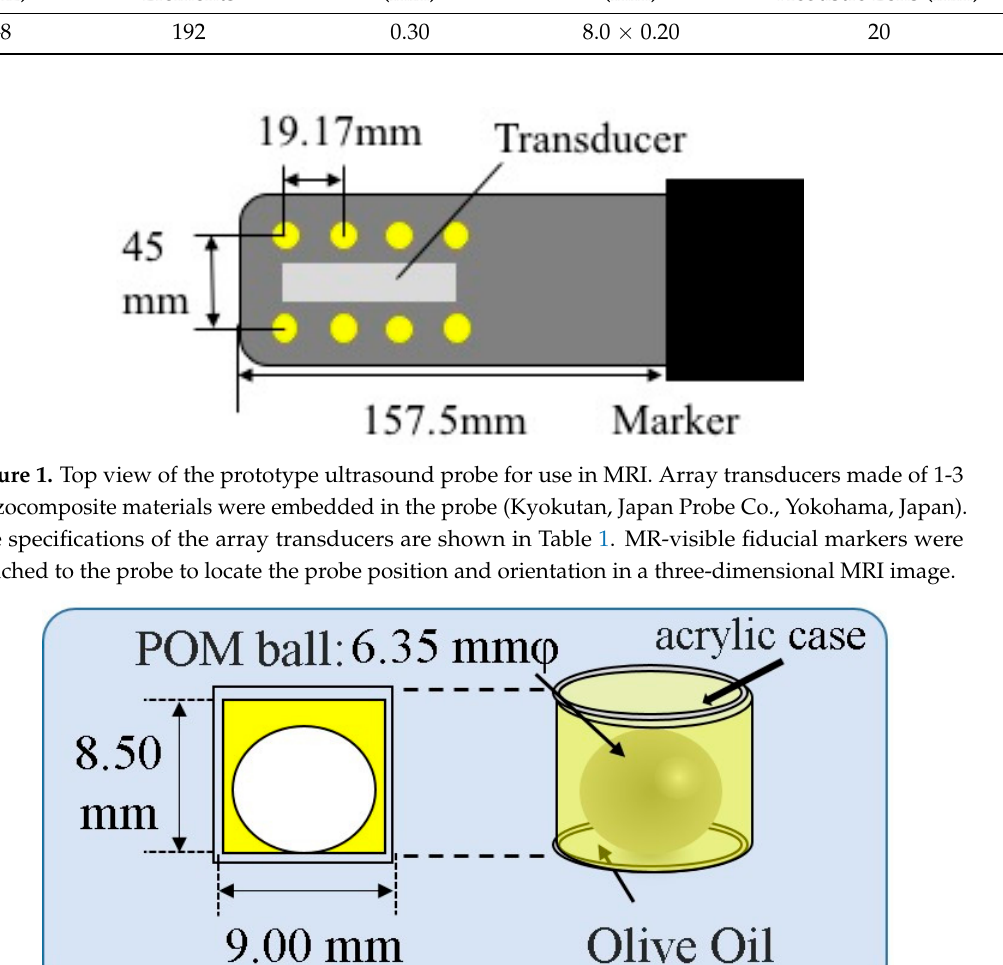
Figure 2. MR-visible fiducial marker. (POM: polyoxymethylene).